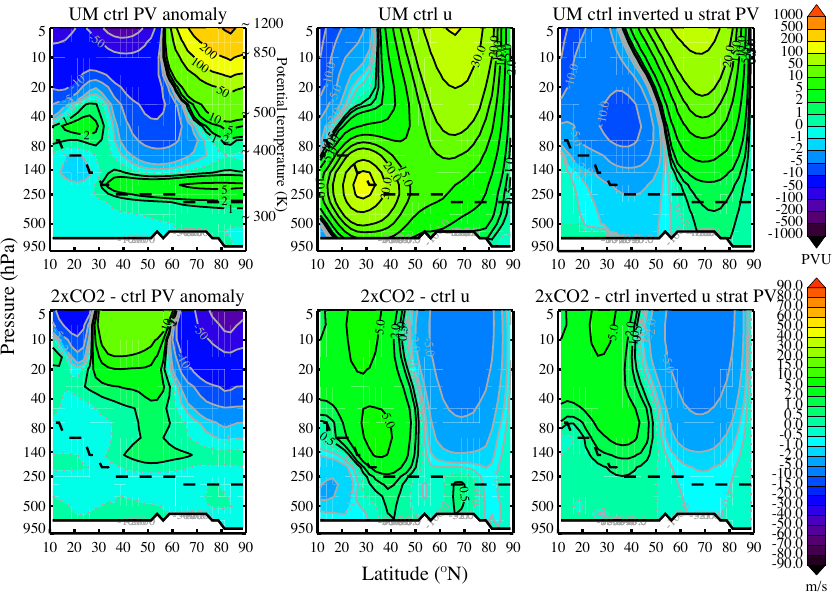
Fig. 5. February mean, zonal mean monthly PV anomaly (in PVU, left column), UM zonal wind (in m s − 1 , middle column) and wind obtained from inverting the stratospheric PV between 400 K and 1250 K (in m s − 1 , right column), for the UM control run (top row), and the difference between the UM doubled CO 2 run minus the UM control run (bottom row), for the NH as a function of pressure (hPa) and latitude ( ◦ N). The position of the control run tropopause (as measured by the 2 PVU isopleth) is indicated by the thick dashed line, while the thick solid line near the bottom of each figure represents the lower boundary of the inversion domain (interpolated back to pressure coordinates). The approximate values of the potential temperature (K) at certain pressure levels is indicated to the right of the upper left panel. Contours for the PV anomaly are as in Figure 1 with the zero and ± 1 contour added, contours for the wind fields are at ± 0.5, 1, 2, 5, 10, 15, 20 and then every 10 m s − 1 . Negative values are represented by grey lines and the zero contours by grey dotted lines. The upper color bar corresponds to the PV anomaly fields and the lower color bar corresponds to the wind fields.